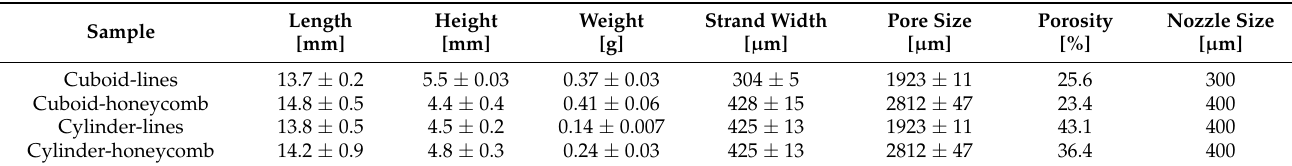
Table 2. Size, weight, and strand width of the 3D printed TC scaffolds (n = 15). Sample